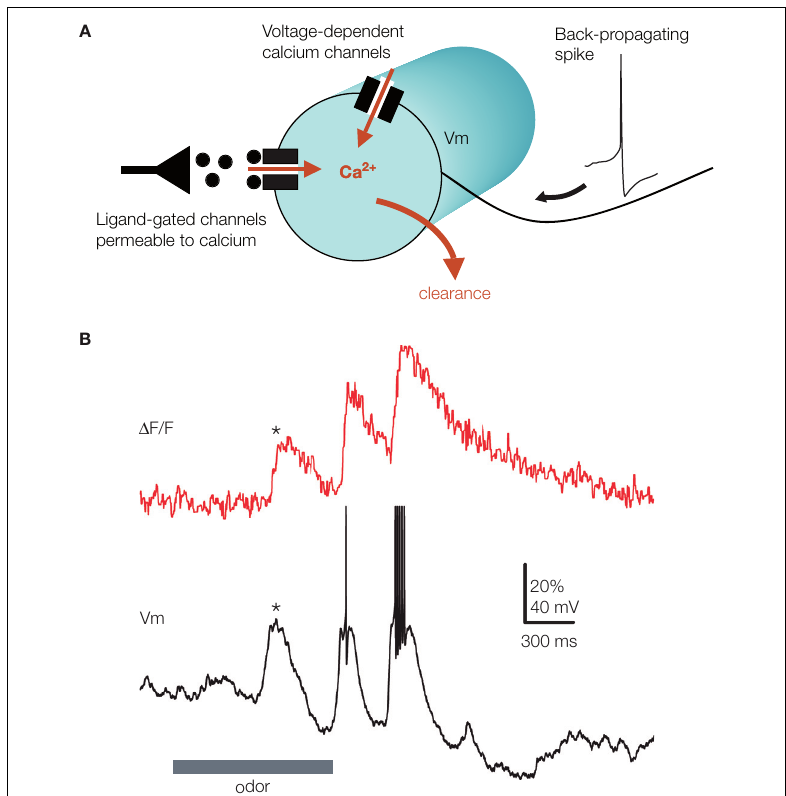
Figure 2 | Projection neuron dendritic calcium signals have multiple components as illustrated in (A) with a simple schematic of a PN-glomerular dendritic compartment (circle). The majors sources of calcium variation are back-propagating spikes triggering fast calcium transients trough high-threshold voltage-dependent calcium-channels, sub-threshold depolarizing activity (through low-activated voltage-dependent calcium-channels, possibly also by activation of calcium-permeable ligand-gated channels), and clearance. (B) Calcium signals are not always correlated with spiking. Simultaneous fl uorescence and voltage PN-recording illustrates the occurrence of spike-independent components in the glomerular signal. Odor-evoked depolarizing synaptic input to the PN marked (*) can produce a signifi cant calcium elevation in the absence of